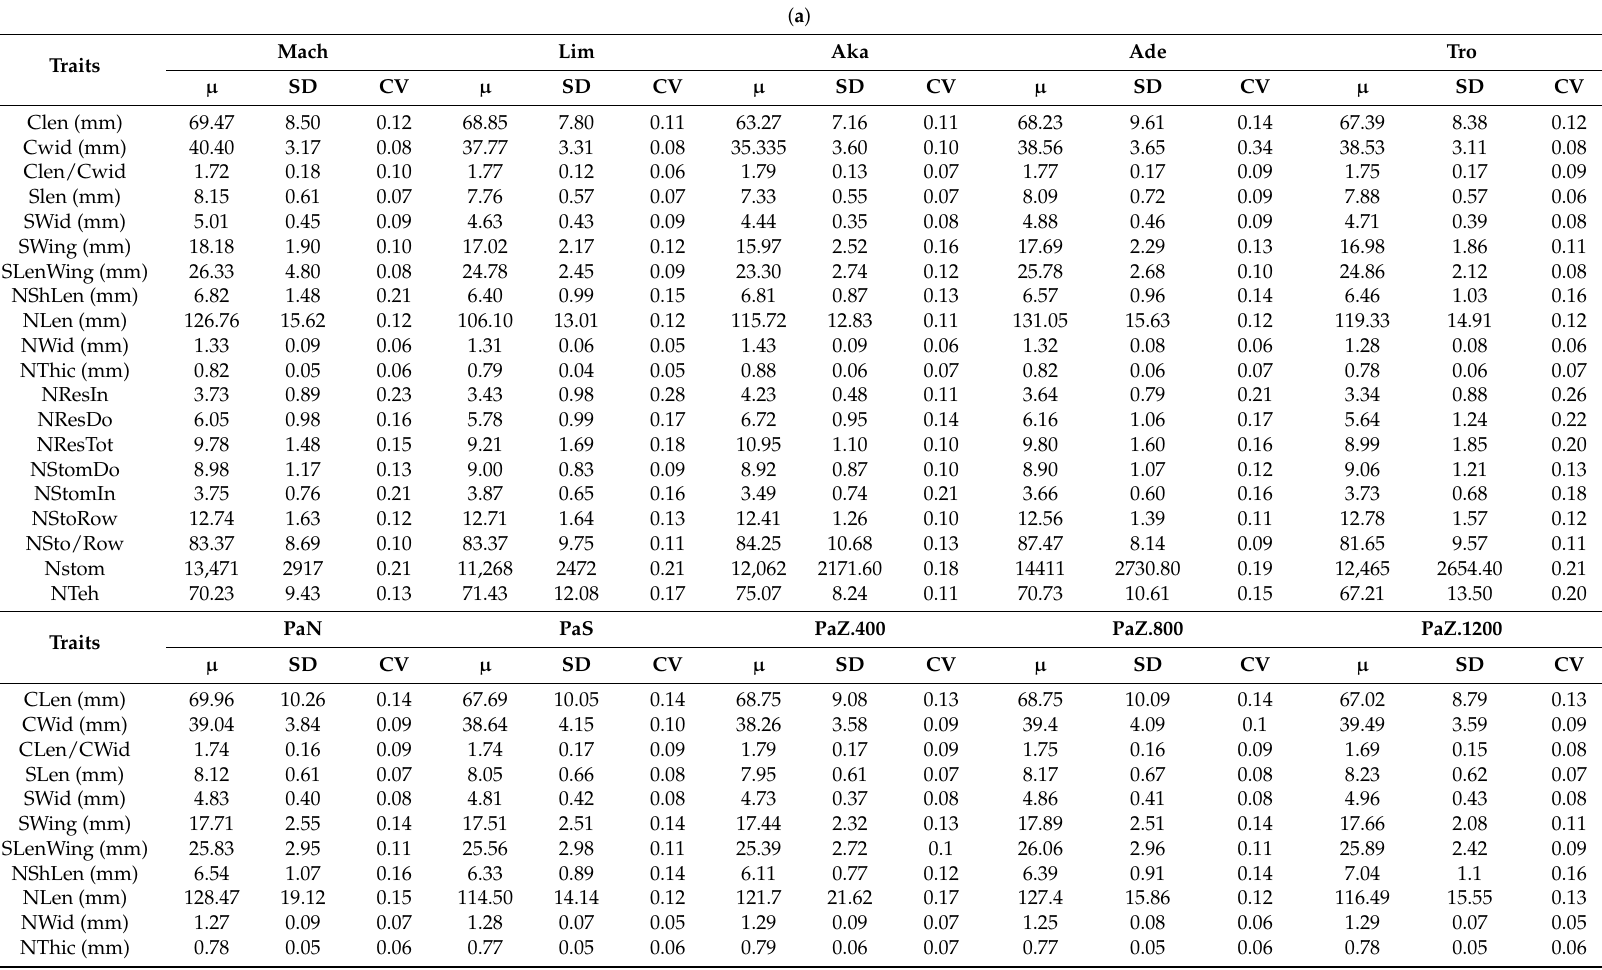
Table 4. Statistical measures (average value, standard deviation, and coefficients of variance) of morphological and anatomical traits in P. brutia from Cyprus: ( a ) the values in each sampled subpopulations and ( b ) the overall value of morphoanatomical traits in P. brutia